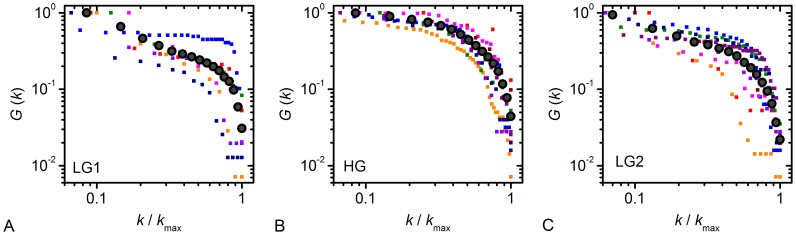
Cumulative degree distributions of functional networks for three of the five regimes analyzed.Values obtained from all 9 islets are plotted in different colors and the larger black circles indicate their average for low glucose prior to stimulation (A), high glucose (B), and low glucose after stimulation (C). The node degree distributions decay roughly linearly before a drop-off in the tail, thereby indicating a broad-scale nature of the networks.